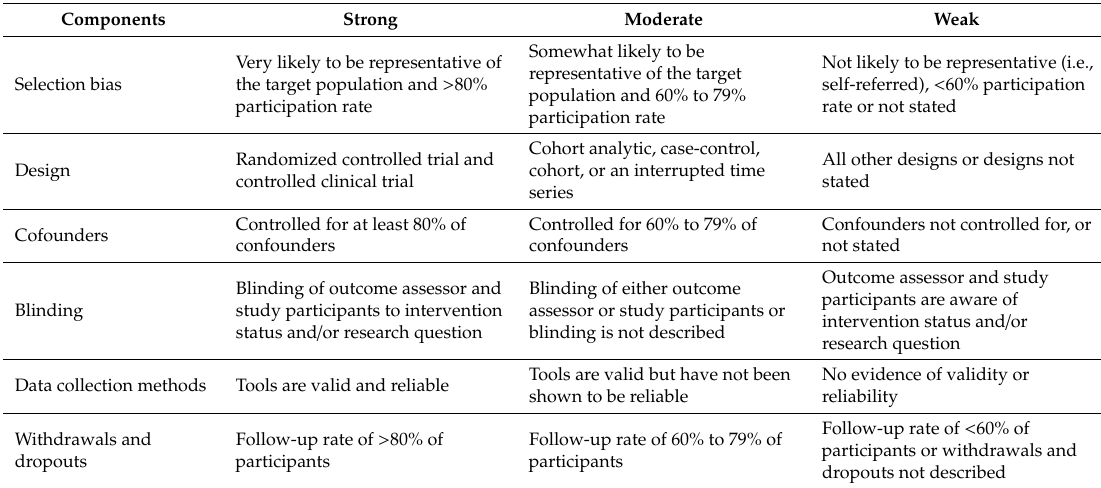
Table 2. Quality assessment components and ratings for E ff ective Public Health Project